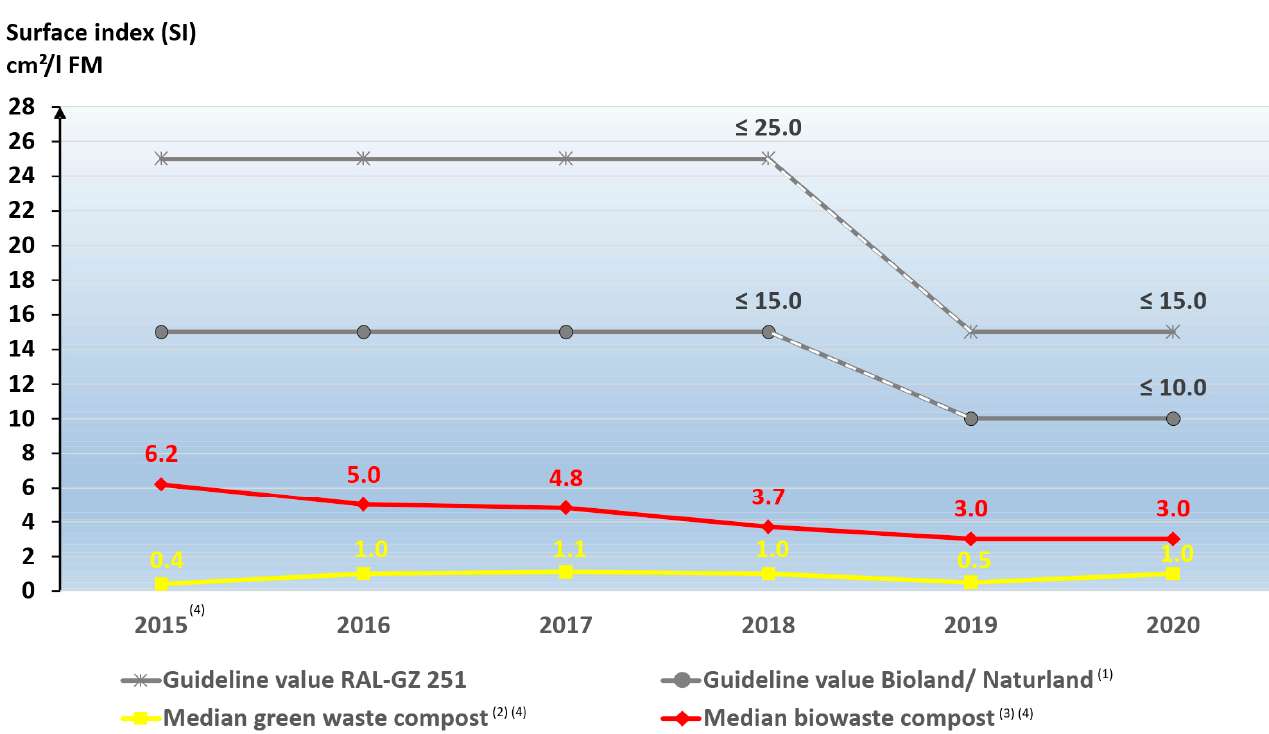
Figure 8. Average content of deformable plastic and film contaminants with high surface area (surface index—SI) of quality-assured biowaste and green waste composts in Germany in 2015–2020 (composts according to RAL-GZ 251 Compost of BGK in Germany) (1) (5) . (1) Guideline values ( ≤ ) according to Bioland/Naturland guidelines (5/2014 to 3/2020). (2) n = 1138 in 2015, n = 1488 in 2016, n = 1518 in 2017, n = 1636 in 2018, n = 1803 in 2019, n = 1942 in 2020, data from RAL quality assurance 251 (BGK, 2016–2021). (3) n = 1772 in 2015, n = 1857 in 2016, n = 1843 in 2017, n = 1900 in 2018, n = 1874 in 2019, n = 1899 in 2020, data from RAL quality assurance 251 (BGK, 2016–2021). (4) n = 1138 (green waste composts) and 1772 (biowaste composts) in 2015, as not all composts were analyzed for the new “surface index” parameter in 2015. (5) Surface index: standardized area measurement of foreign matter, usually light film plastics and composites with a high surface area are recorded, which only account for a small proportion in the gravimetric measurement, but are